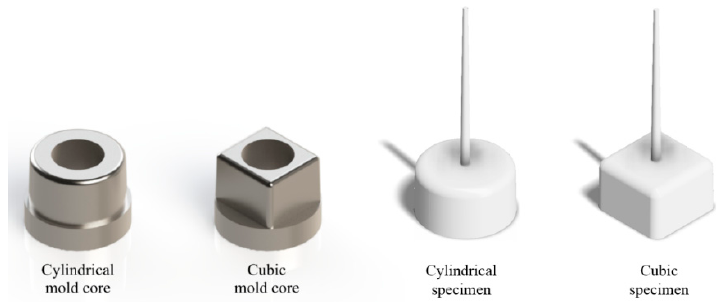
Figure 1. Mold cores and specimens with cylindrical and quadratic geometry.